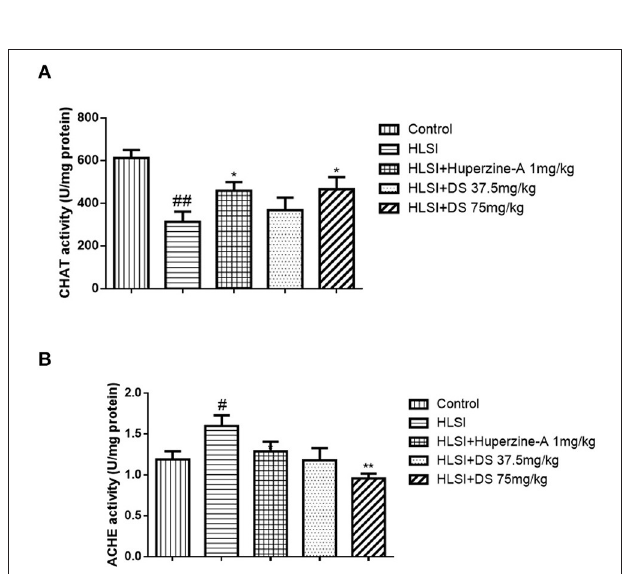
FIGURE 12 | The effect of DS on acetylcholine-related enzymes in the hippocampus of rats. All values are means ± SEM ( n = 6–8) for the following: (A) the AChE activity in the hippocampus and (B) the ChAT activity. The symbols represent: # p < 0.05 and ## p < 0.01 vs. the control group; * p < 0.05 and ** p < 0.01 vs. the HLSI group.